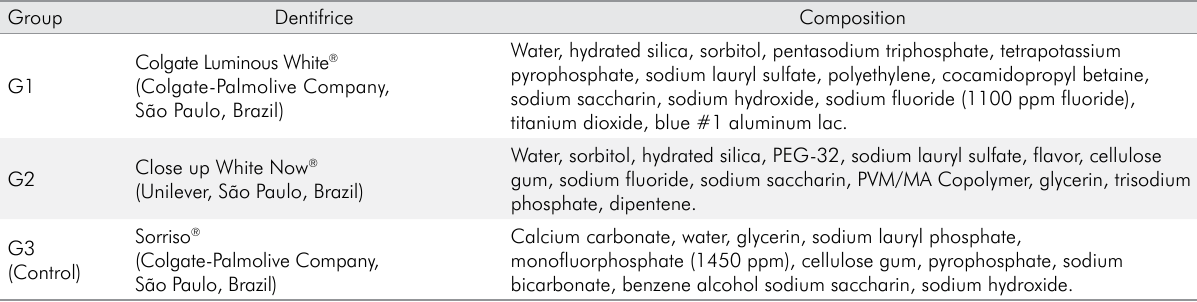
Table 1. Experimental groups, dentifrice and composition.